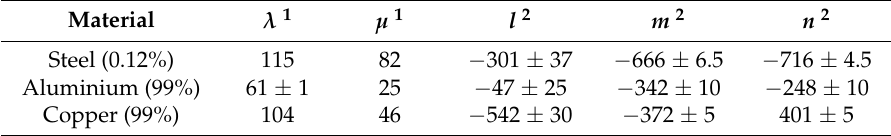
Table 1. Lame and Murnaghan constants (in GPa) for some representative materials. Material λ 1 µ 1 l 2 m 2 n 2 Steel